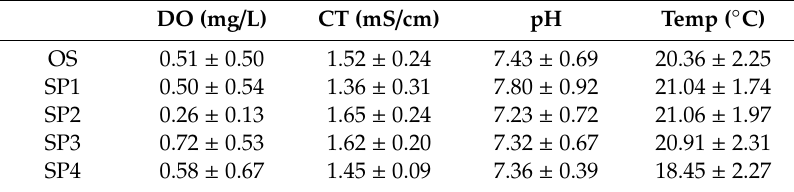
Table 3. Average values for dissolved oxygen (DO), conductivity (CT), pH, and temperature by step and for the overall